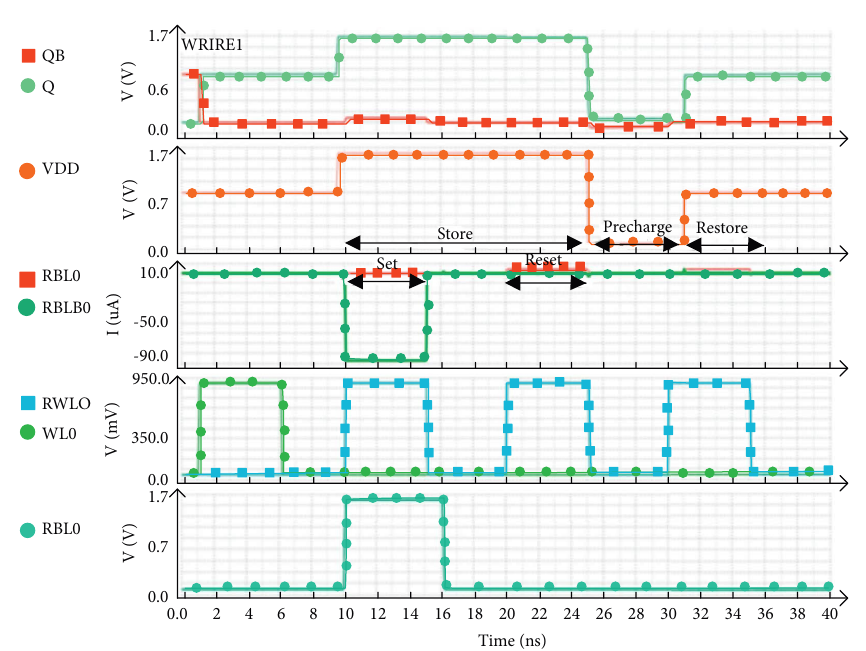
Figure 13: Result of reading data.